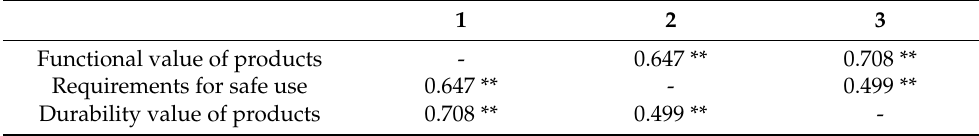
Table 7. Matrix of green design and product life cycle ( N = 324). 1 2 3 Functional value of products -